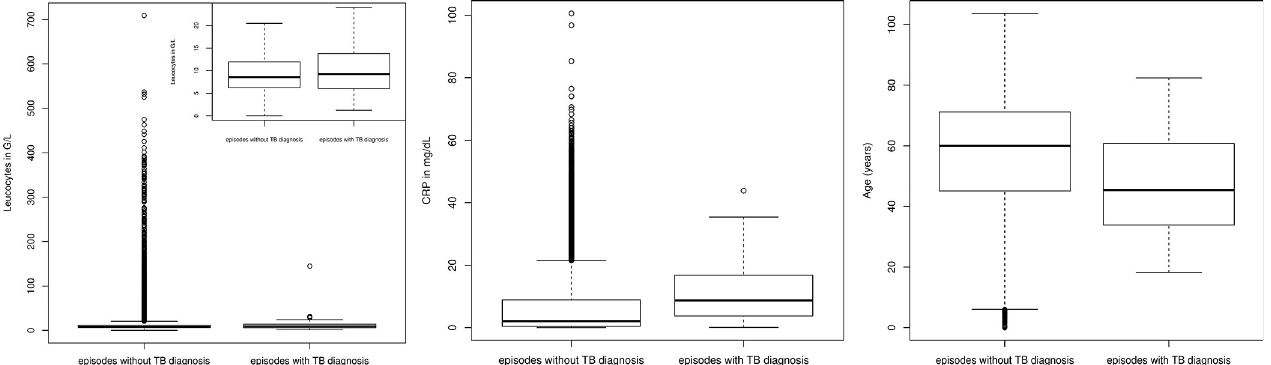
Fig 2. Infection parameters and age in patients with hyponatremia. Patients with TB showed higher leucocyte count (A), higher CRP values (B) and younger age (C) than patients without TB. Boxplots mark first IQR, median, and third IQR. The Whiskers extend to the minimum and maximum, and if outliers exist (shown as open circles), to the smallest and largest value within the interval [first quartile –1.5x IQR; third quartile +1.5x IQR].